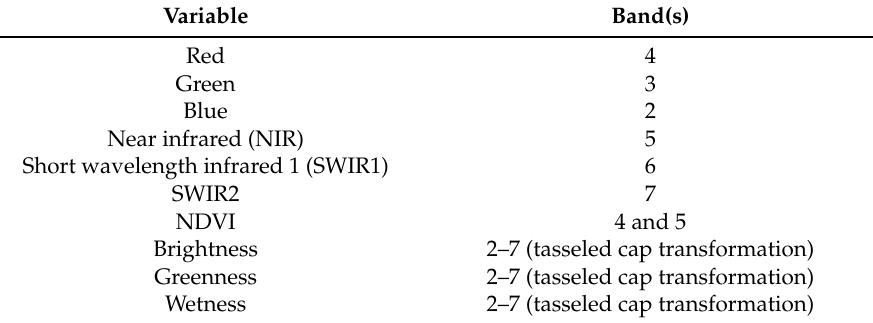
Table 1. Variables derived from the Landsat satellite imagery. Corresponding